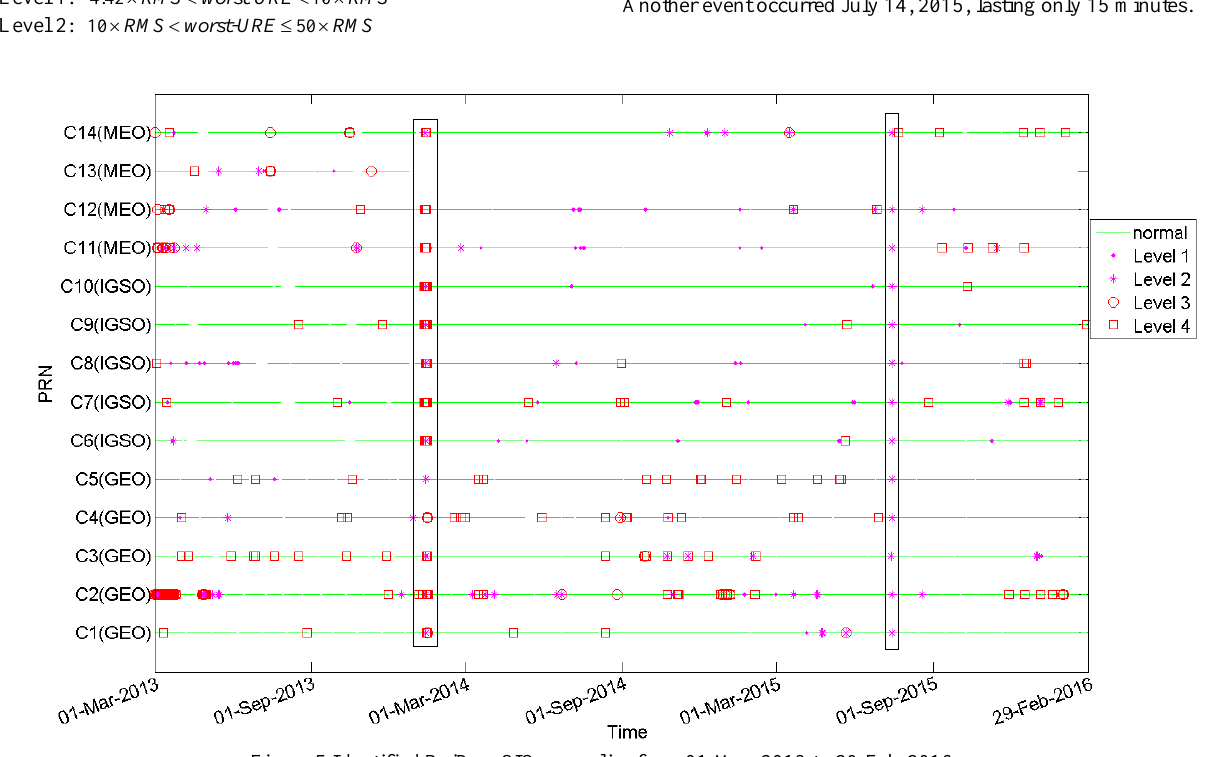
Figure 5 Identified BeiDou SIS anomalies from 01-Mar-2013 to 29-Feb-2016